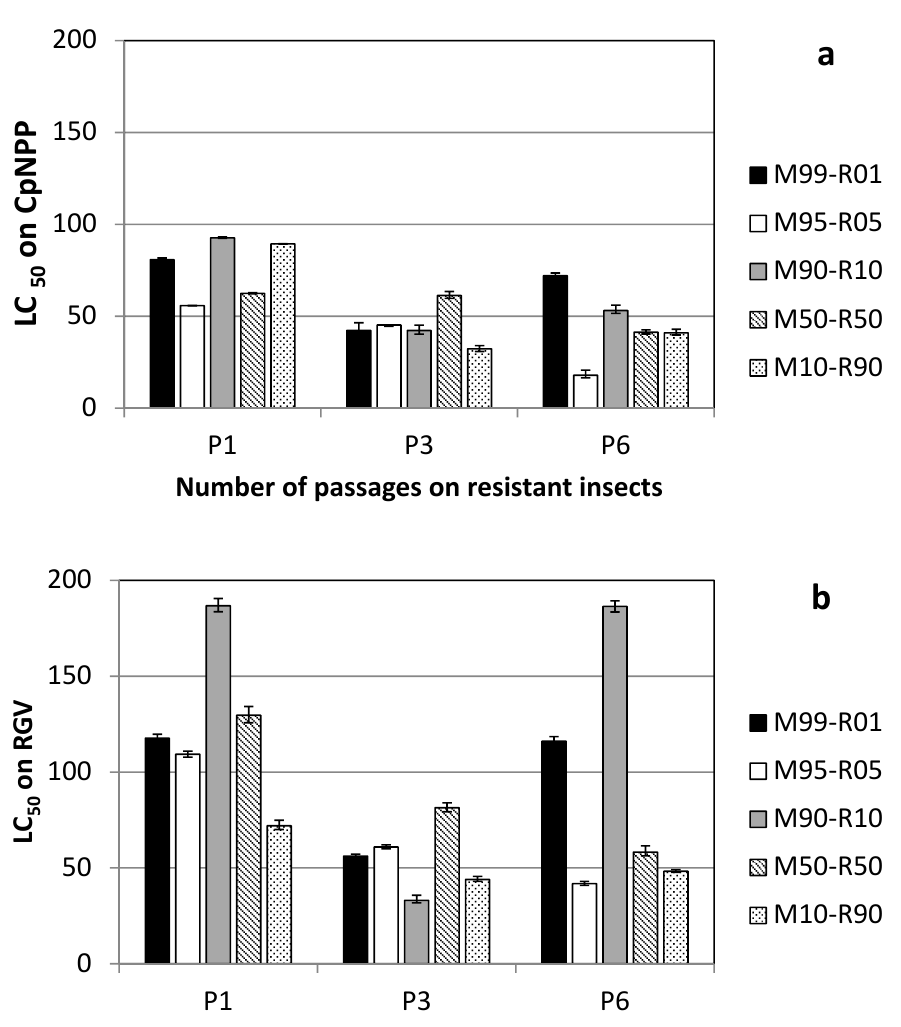
Figure 3. Efficiency (LC 50 ) of the different experimental virus populations replicated on R GV and tested on ( a ) CpNPP and ( b ) R GV . Parental CpGV-M and CpGV-R5 alone had LC 50 s on R GV of 2.22 × 10 6 OB/µL and 22.43 OB/µL, respectively.